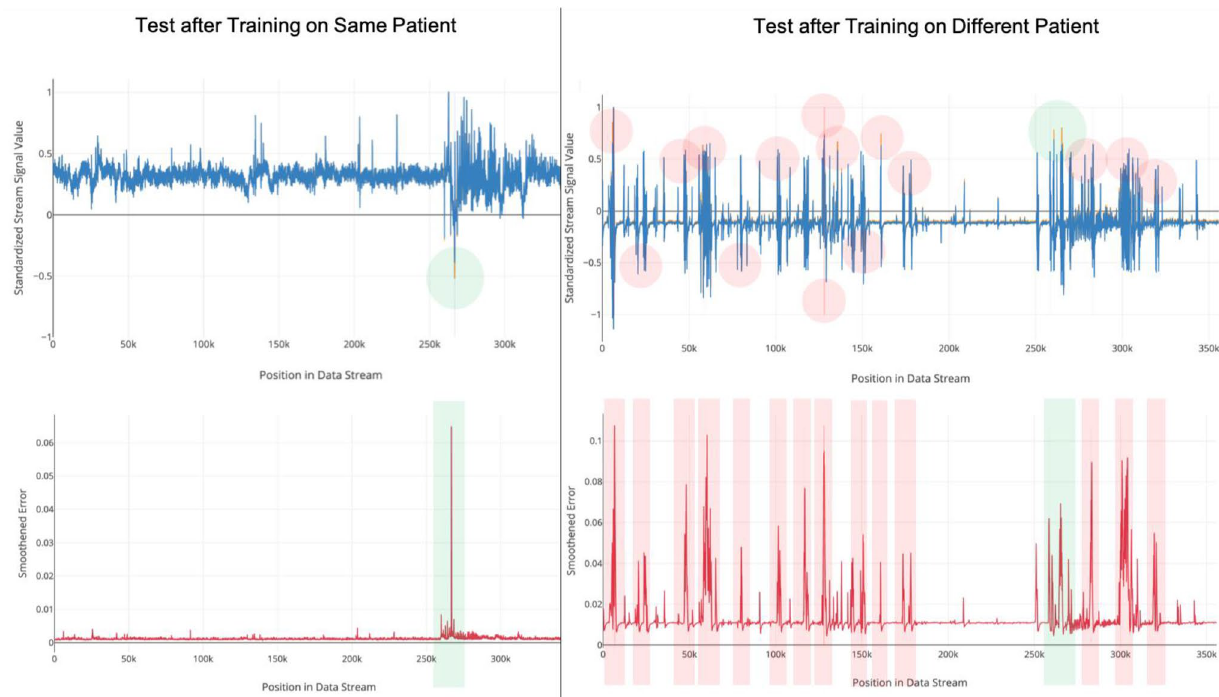
Figure 3. Crossover testing produces a large increase in the number of false positive results. This indicates that trained models are attuned to the unique electrical signal of a given patient. Green shading refers to prediction mismatches that correspond to correctly identified anomalies whereas red shading refers to prediction mismatches that correspond to false